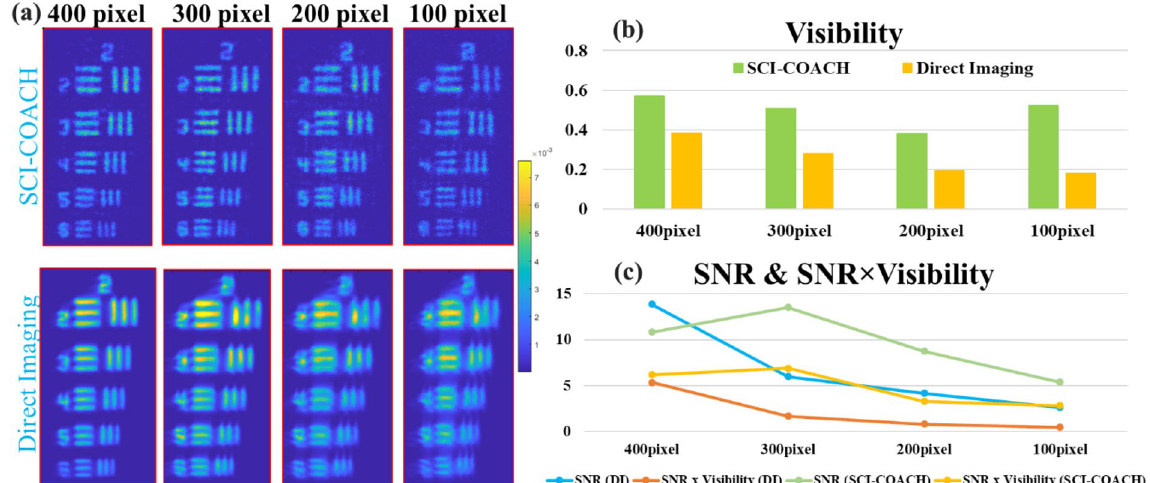
Figure 6. ( a ) Reconstruction and imaging results of SCI-COACH ( R = 40 (cid:31) ) and direct imaging system with annular aperture along with their ( b ) visibility, ( c ) SNR and SNR × Visibility chart.